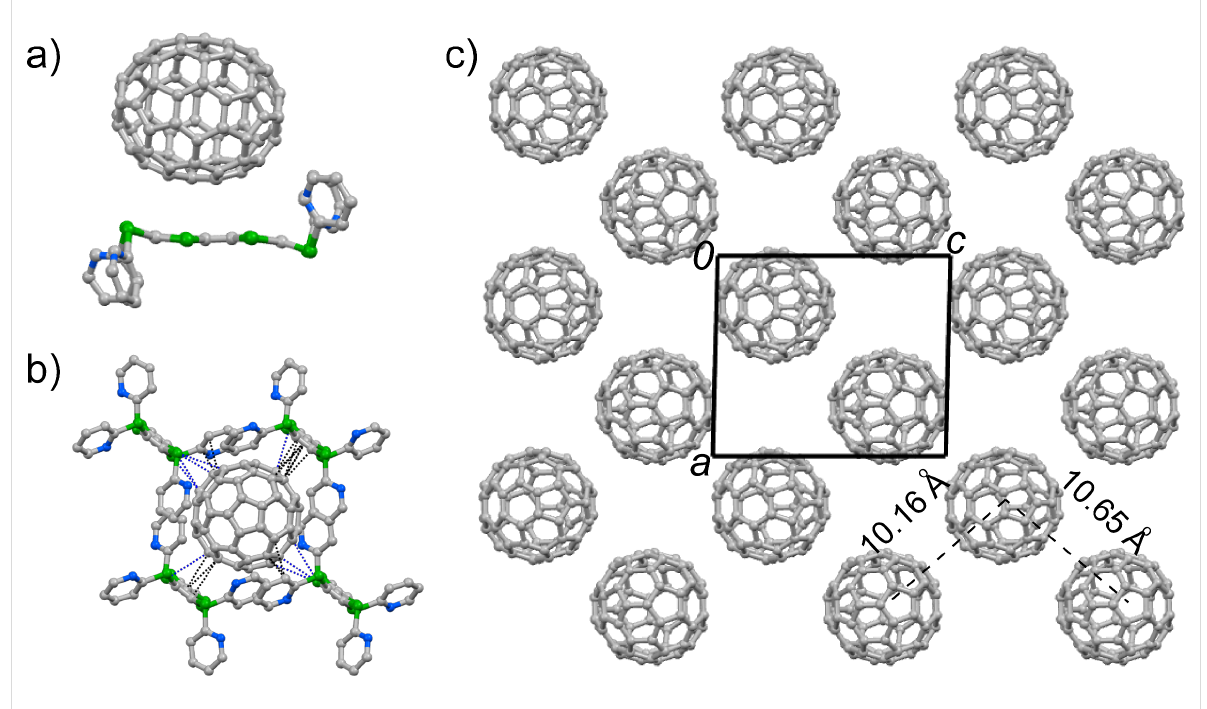
Figure 1: Crystal structure of 5 ·C 70 . a) Unit cell contents viewed along the short axis of 5 ; b) Interactions between 5 and C 70 , where the blue and black dashed lines represent the C–S and C–C contacts, respectively; c) packing motif of C 70 molecules viewed along the b -axis. The grey, blue and green spheres represent carbon, nitrogen and sulfur atoms, respectively, and the hydrogen atoms are omitted for